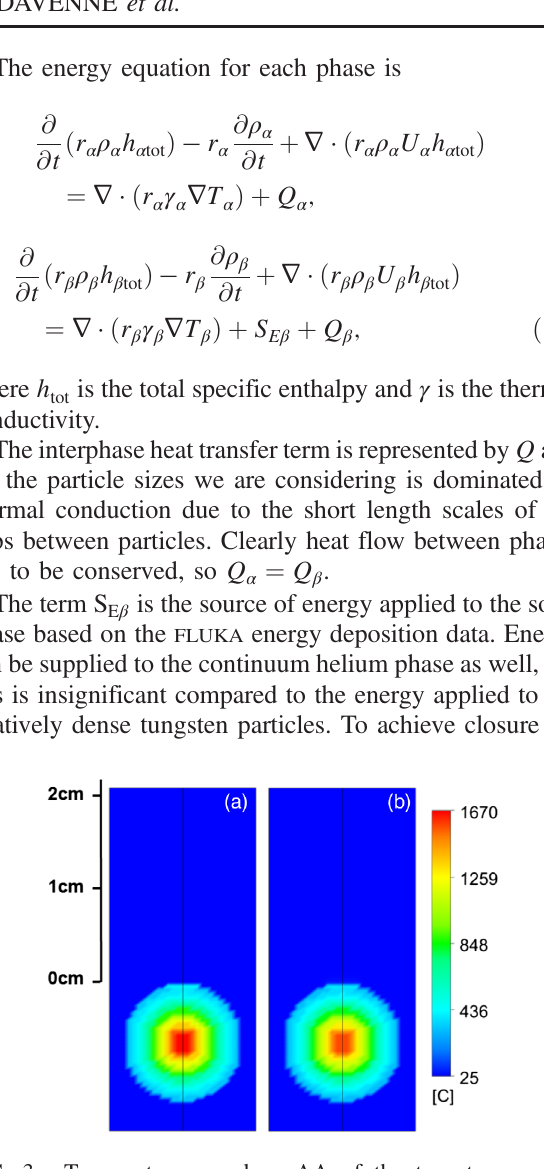
FIG. 3. Temperature on plane AA of the tungsten powder (a) and helium gas (b) immediately after a beam pulse of 3 × 10 12 protons.